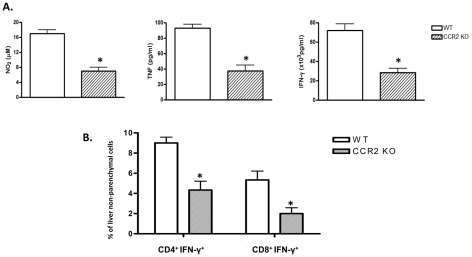
Absence of CCR2 signaling reduces TNF, NO and IFN-γ production during T. brucei infection.At day 6 post infection, A) production of TNF, NO2 (as measure of NO) and IFN-γ by unstimulated liver non-parenchymal cells after 24 hours of in vitro culture and B) percentages of CD4+IFN-γ+ and CD8+IFN-γ+ cells within the liver non-parenchymal cell fraction were determined in WT (white bars) and CCR2 KO (grey bars) mice. Data are shown as mean ± SEM of three individual mice of one of three independent experiments performed. *, significantly (p<0.05) lower compared to WT mice.